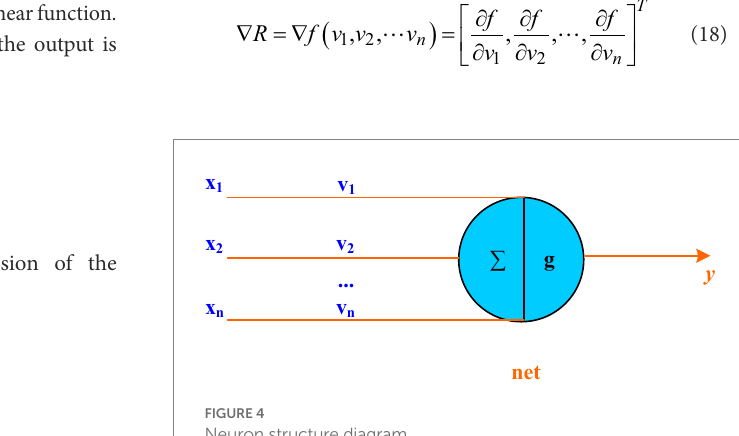
FIGURE 4 Neuron structure